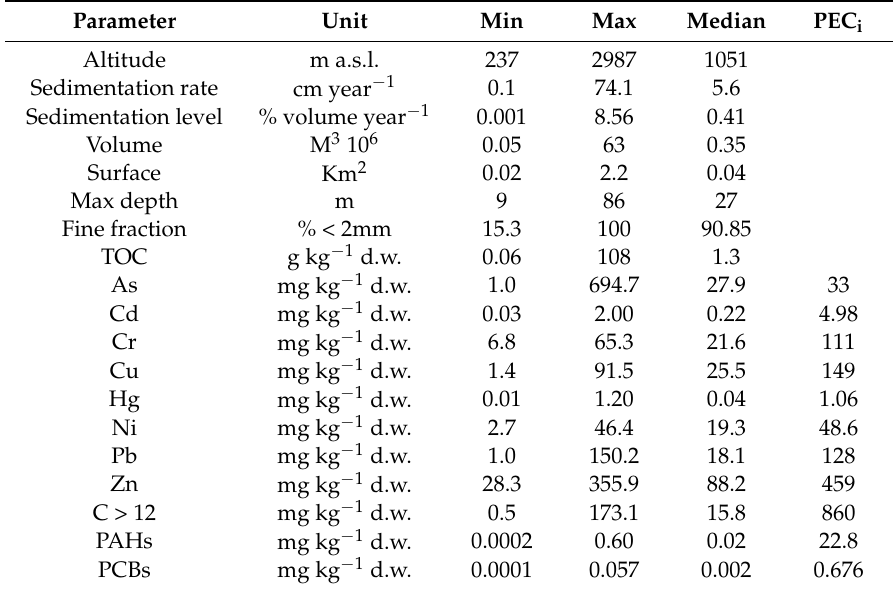
Table 1. Range (min, max) and median value of parameters descriptive of 20 Subalpine reservoirs considered for sediment analysis. Concentrations of trace elements and organics in sediments (analyzed on <2 mm grain size fraction) are reported. Concentrations of organics are normalized to %TOC. Probable Effect Concentrations (PEC i ) are also reported for each contaminant according to MacDonald et al. [41] and Marshall et al. [42]. a.s.l. = above sea level; d.w. = dry weight.